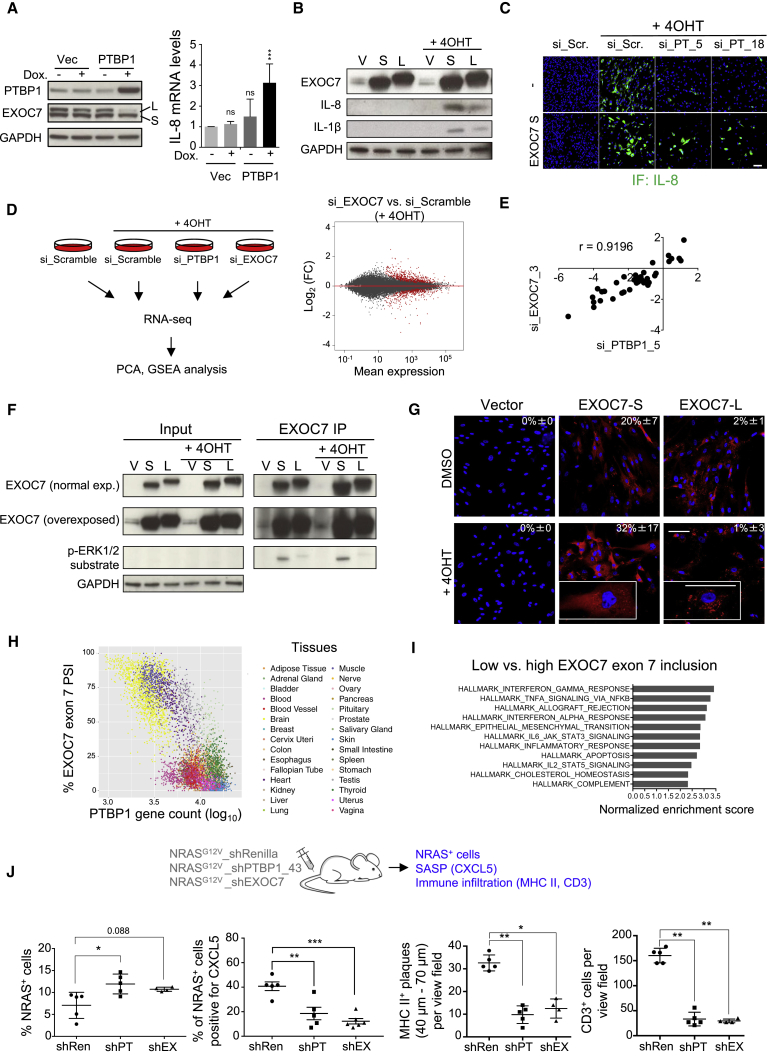
PTBP1 Regulates Alternative Splicing of EXOC7 to Control the SASP(A) SASP expression and EXOC7 isoform switching following PTBP1 overexpression in IMR90 cells. Immunoblot of protein extracts (left) and mRNA analysis by qRT-PCR (right) 2 days after induction of PTBP1 expression with doxycycline (Dox). Normalized and compared with Vec − Dox. Data represent mean ± SD (n = 5). ∗∗∗p < 0.001; ns, not significant; one-way ANOVA (Dunnett's test).(B) Comparison of SASP production following overexpression of EXOC7-S (S) and EXOC7-L (L) 4 days after 4OHT and doxycycline treatment of IMR90 ER:RAS cells by immunoblot analysis. v, empty vector.(C) Effect of EXOC7-S on the SASP downregulation caused by PTBP1 knockdown. Representative IF images of IL-8 of IMR90 ER:RAS cells without (−) and with doxycycline treatment (EXOC7 S) 8 days after 4OHT induction. Scale bar, 100 μm.(D and E) Effect of EXOC7 depletion on the SASP (D). Left: experimental design. Right: mean expression (average of the normalized read counts for 3 replicates) in relation to log2(FC) for the indicated comparison. Significantly changing genes are highlighted in red. (E) Correlation between the expression of SASP genes upon PTBP1 and EXOC7 siRNA-mediated knockdown.(F) Comparison of EXOC7-S and EXOC7-L phosphorylation assessed by EXOC7 immunoprecipitation followed by immunoblotting. Experimental details as in (B).(G) Comparison of EXOC7-S and EXOC7-L localization to the plasma membrane in proliferating and senescent cells. Quantification of cells showing the diffuse EXOC7 pattern. Data represent mean ± SD (n = 3). p < 0.01, comparing EXOC7-S + DMSO with either Vector + DMSO or EXOC7-L + DMSO; p < 0.05, comparing EXOC7-S + 4OHT with either Vector + 4OHT or EXOC7-L + 4OHT; two-way ANOVA (Bonferroni’s test). Experimental details as in (B). Scale bar, 100 μm.(H) PTBP1 expression versus EXOC7 exon 7 inclusion in data from the Genotype-Tissue Expression (GTEx) project.(I) Top 11 hallmarks with normalized enrichment score >2 and false discovery rate <0.05 in genes with expression positively correlating with EXOC7 exon 7 skipping in GTEx samples.(J) Effect of EXOC7 knockdown on the immune surveillance response. Top: experimental design. Bottom: quantification of NRAS+ mouse hepatocytes, CXCL5 expression in NRAS+ hepatocytes, and infiltrated MHC II+ and CD3+ cells 6 days after transposon delivery of NRASG12V_shRenilla (n = 5), NRASG12V_shPTBP1 (n = 4), or NRASG12V_EXOC7 (n = 4). Data represent mean ± SD. ∗p < 0.05, ∗∗p < 0.01, ∗∗∗p < 0.001. Comparisons with NRASG12V_shRenilla, one-way ANOVA (Bonferroni’s test).See also Figure S8.